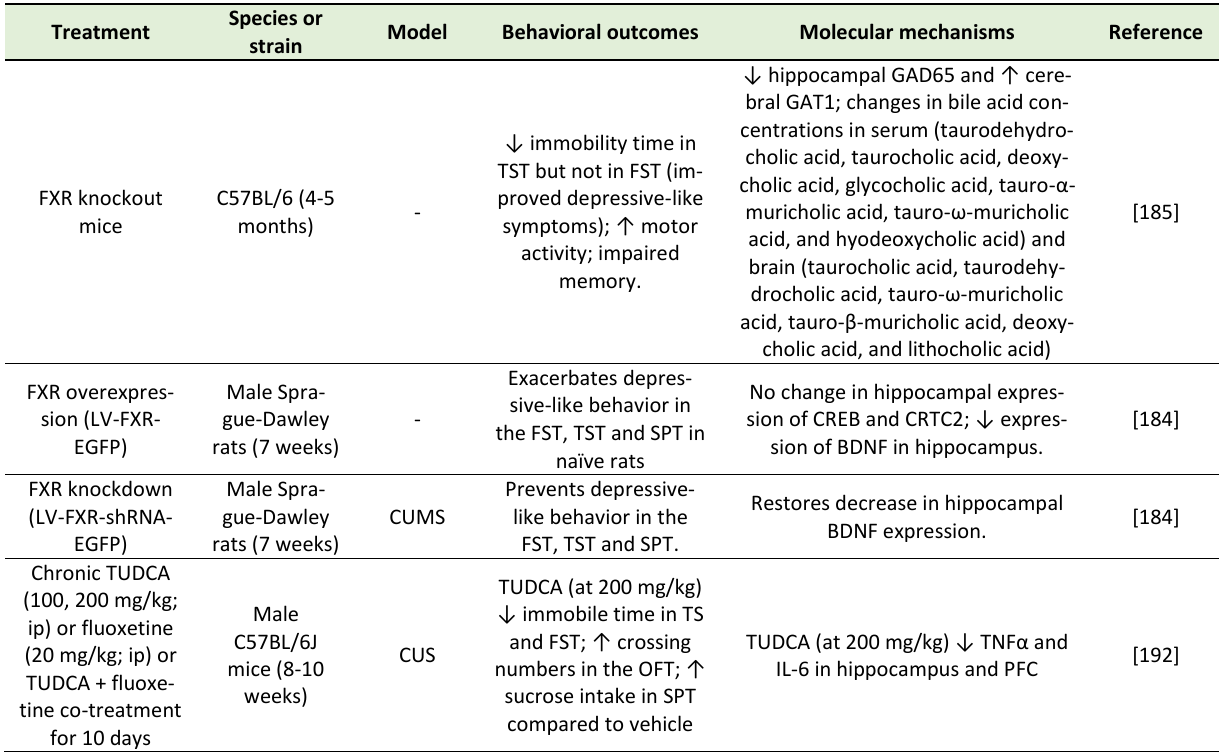
TABLE 6. Studies investigating the effects of bile acids on depressive-like behavior.